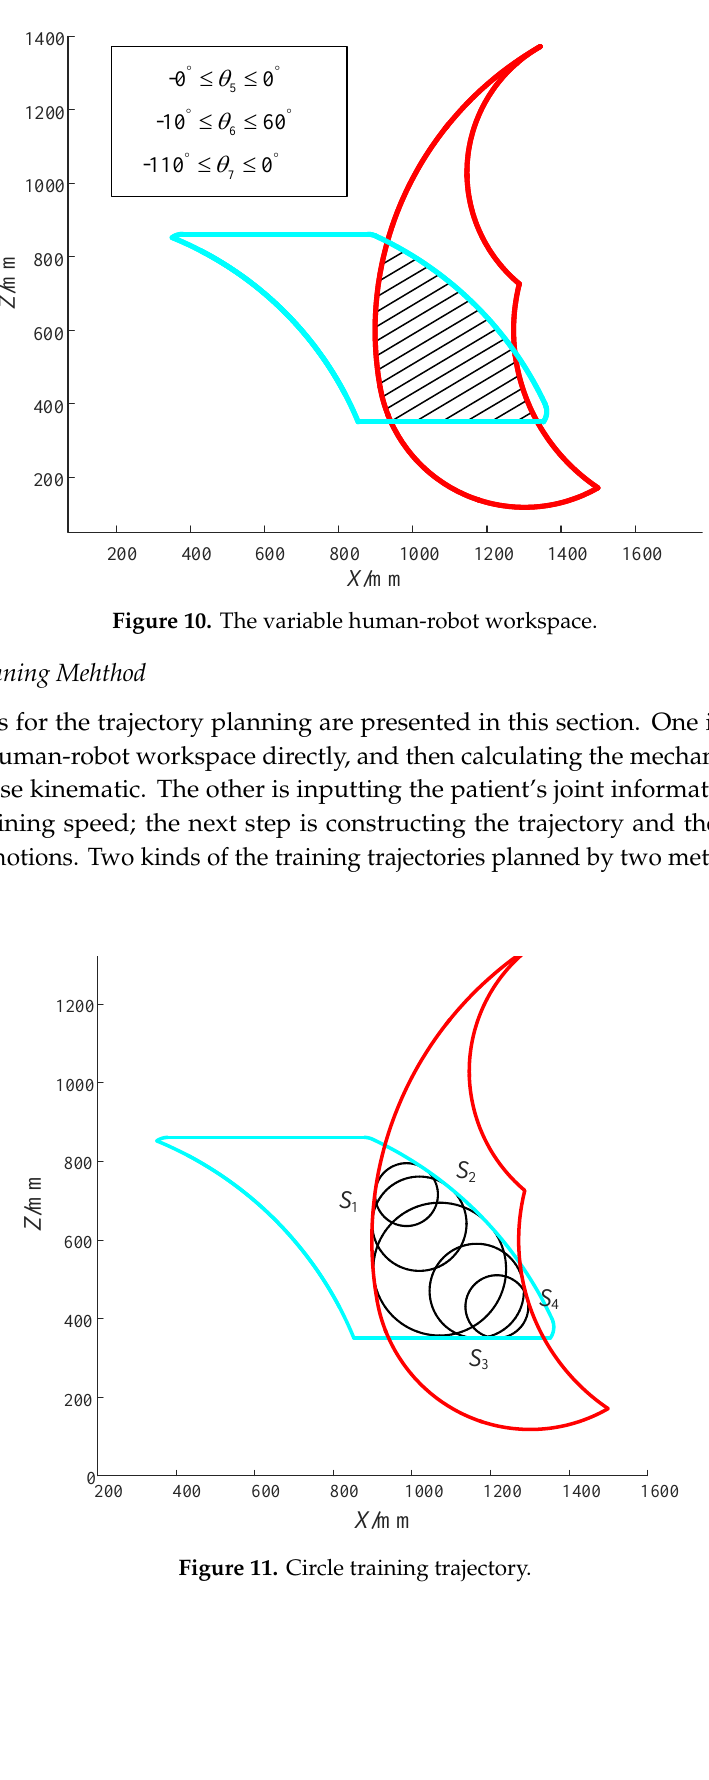
Figure 12. Spherical ellipse training trajectory. The spherical ellipse training trajectory is used for the hip circumduction rehabilitation, and it is planned depending on the patient ’s joint ROM through the second method. To guarantee the training effect of the hip joint, the patient ’s leg is left straight in the circumduction training. The rotation center